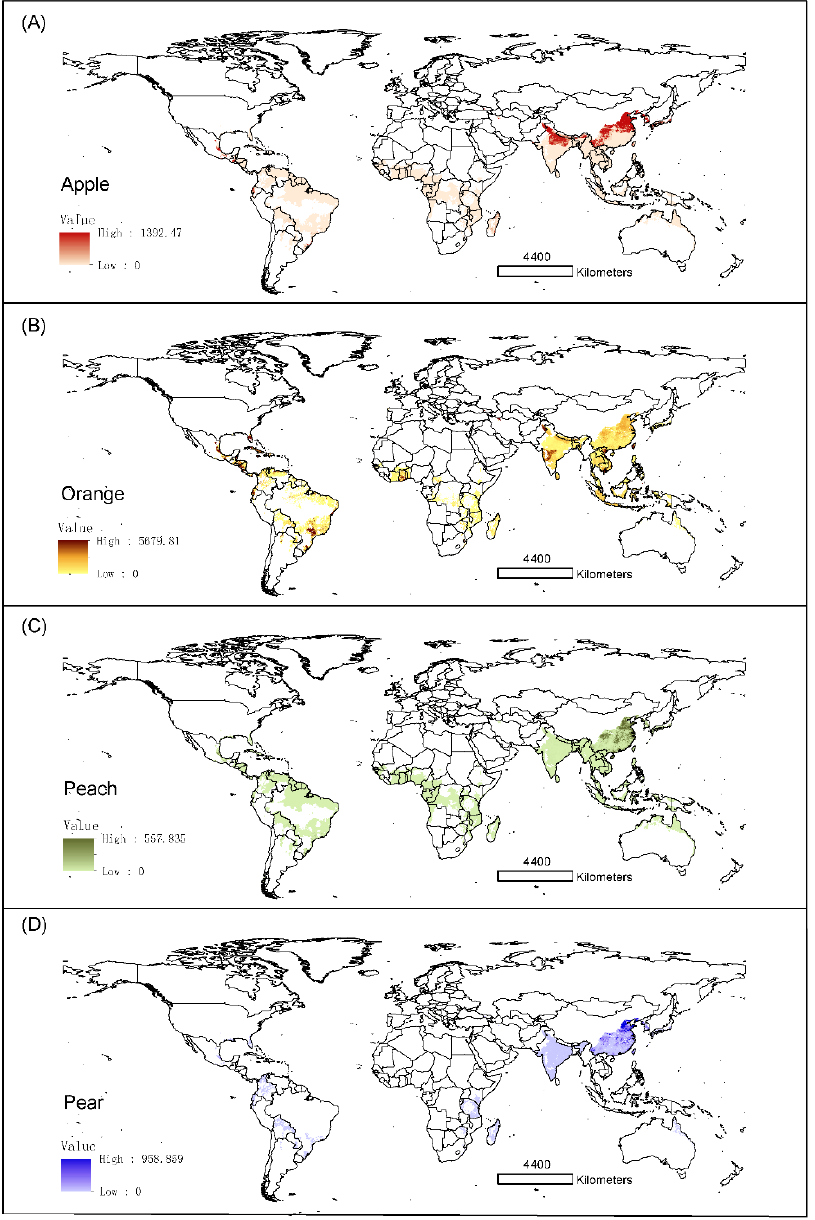
Figure 3. Areas of four fruit species at risk of attack by B. dorsalis in the potential seasonal distribution habitats. The value in each plot shows the harvested area (hectare). ( A ) apple; ( B ) orange; ( C ) peach; ( D ) pear.